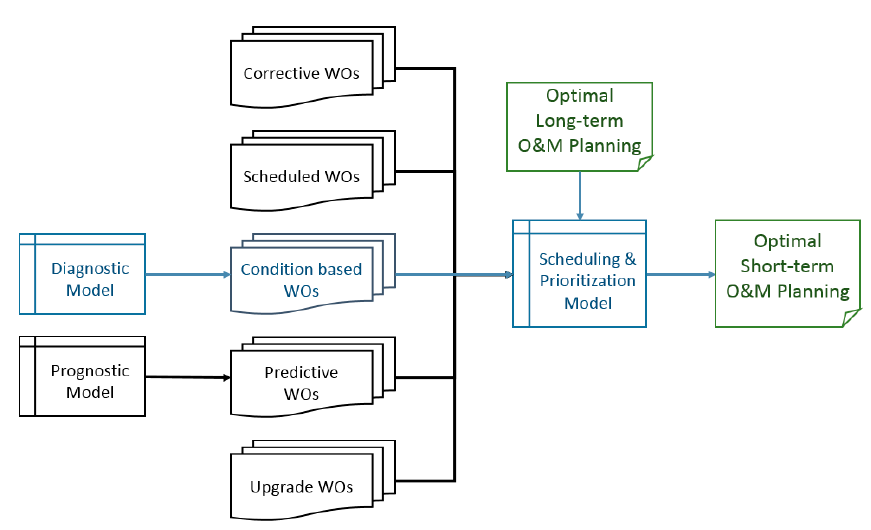
Figure 11. Framework for optimal short-term O&M planning of offshore wind farms.